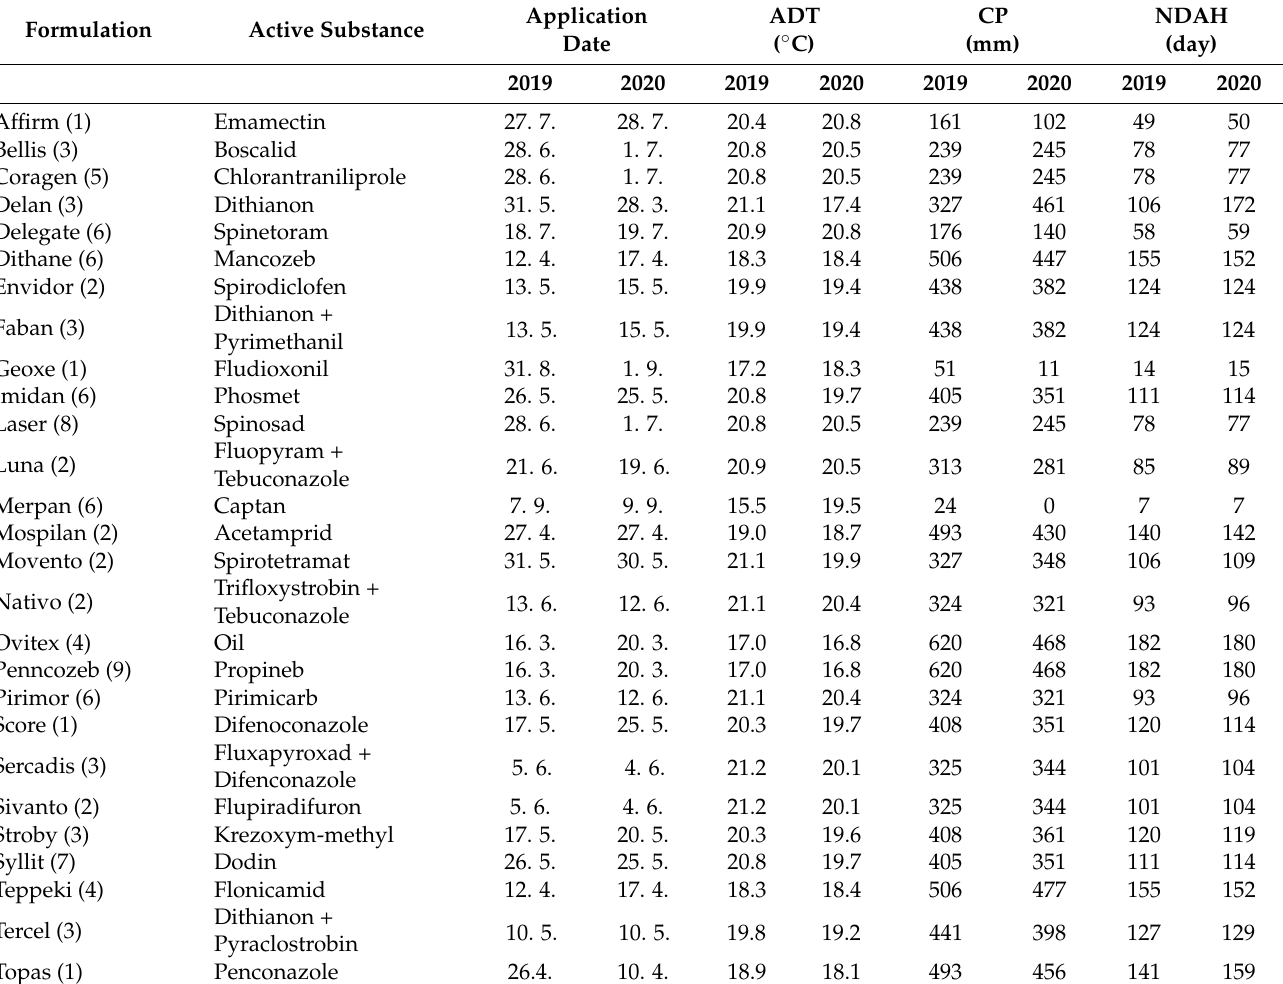
Table 1. Pesticide formulation, application period, and weather parameters for the period from